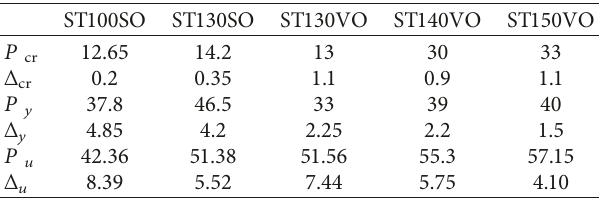
Figure 7: Comparison of voided RC slabs having a variable thickness. Table 3: Test results of the slabs (solid and